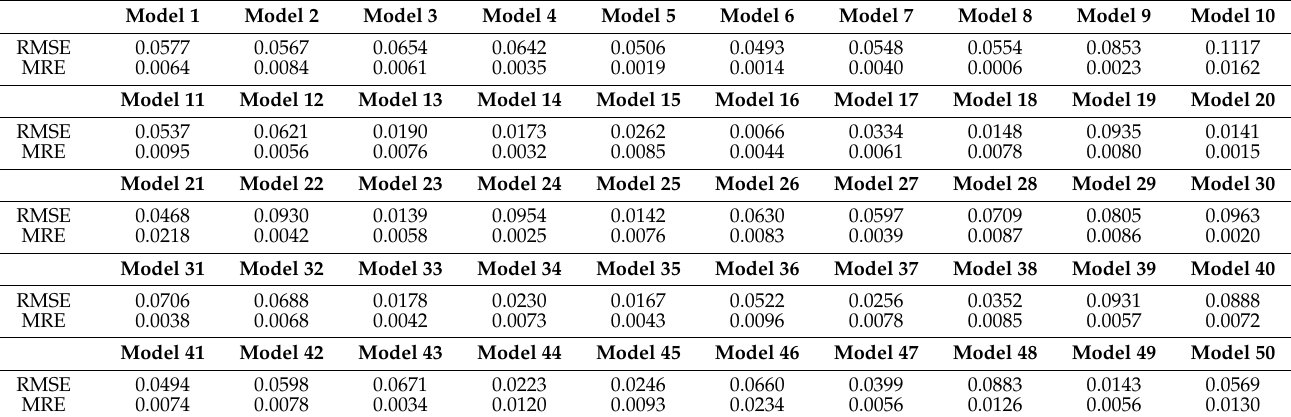
Figure 8. The comparison of actual FVC and predicted FVC results. ( a – e ): Directions 1–5. Table 2. Model